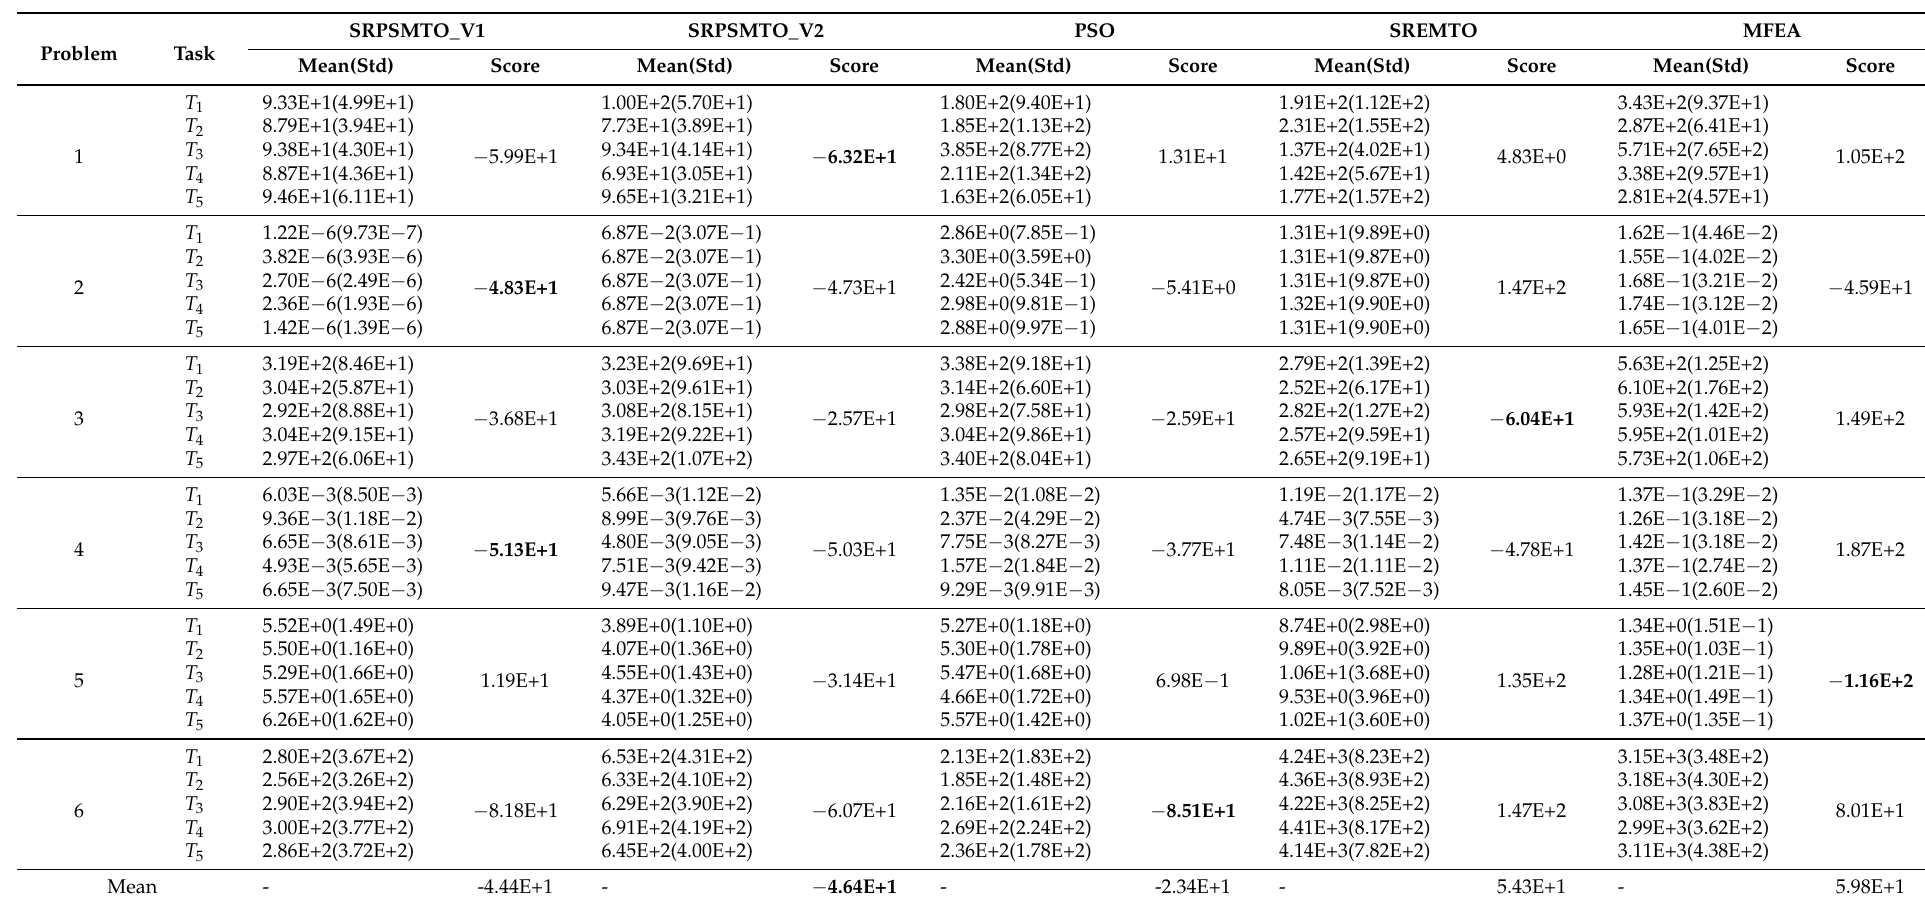
Table 6. Comparison of SRPSMTO (SRPSMTO_V1 and SRPSMTO_V2), PSO, SREMTO and MFEA in terms of the means, bracketed standard deviations and scores of the best achieved FEVs over 30 runs on test suite 2. The best results are shown in bold.